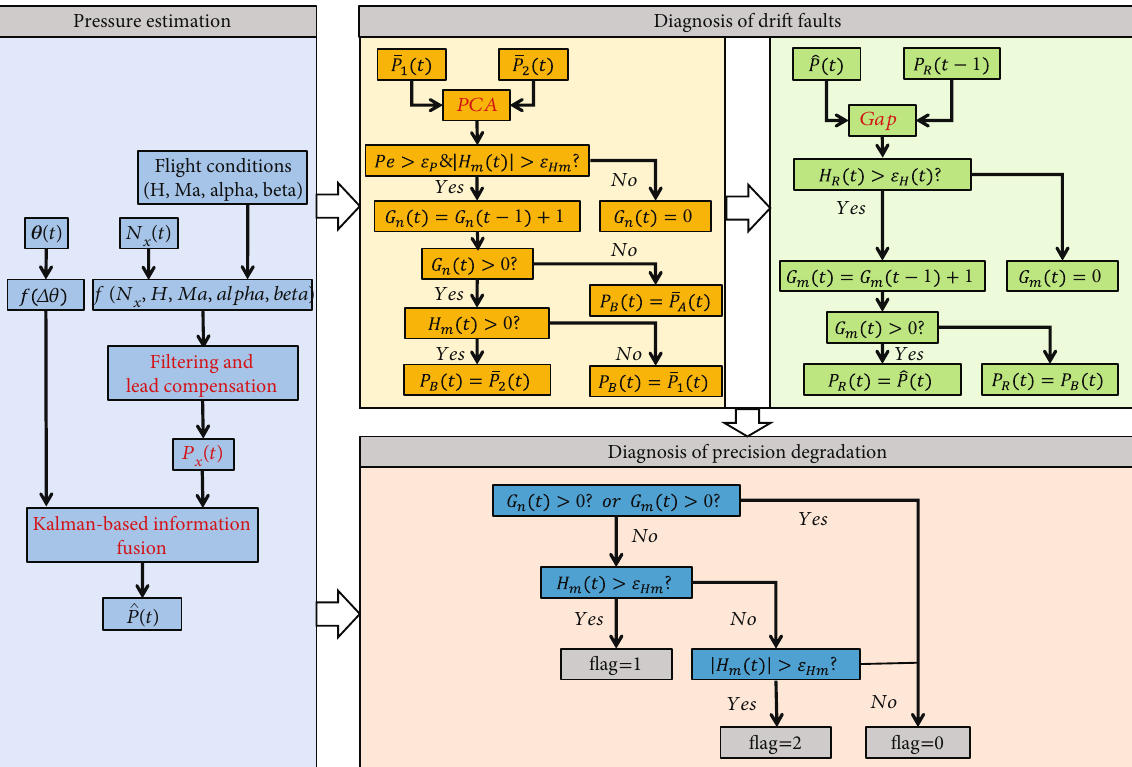
Figure 10: Principles of fault diagnosis and isolation algorithms.